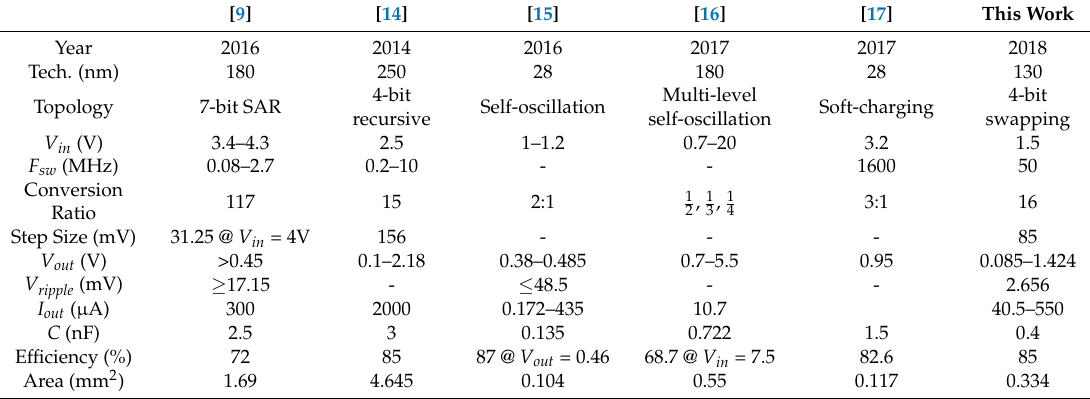
Table 4. Comparison between the proposed SSC-DVS converter and the previous voltage converters.